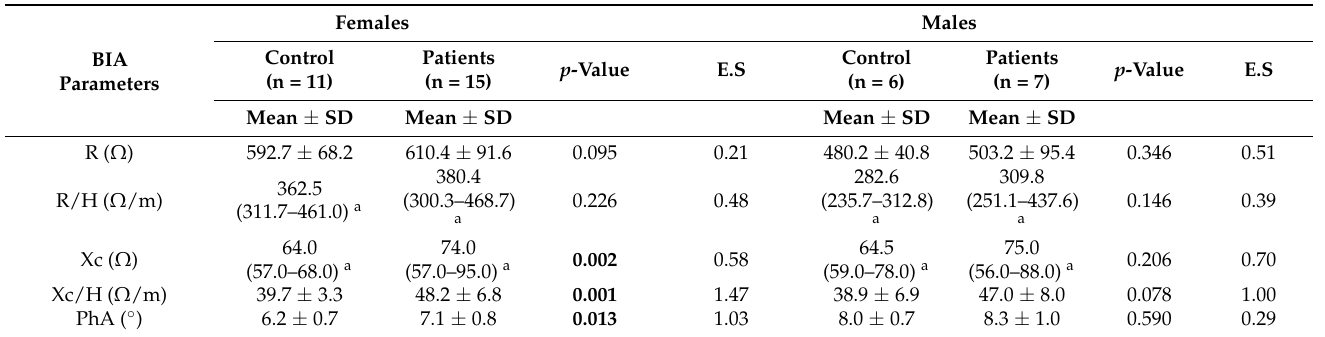
Table 2. Bioelectrical impedance parameters among patients with CAH21OHD and the control group separated by sex.